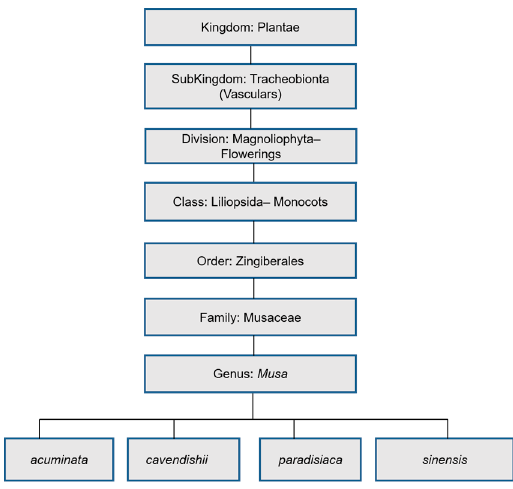
Figure 2. Scientific classification of Musa genus.